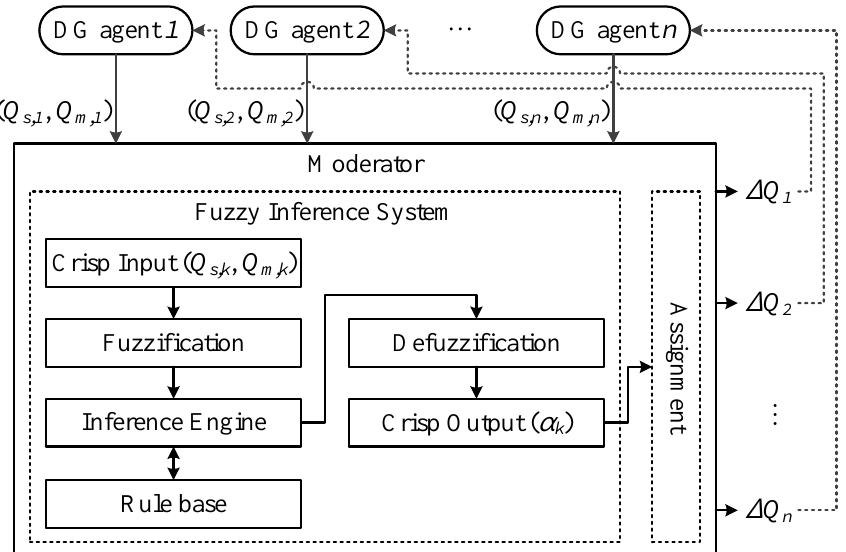
Figure 4. Configuration of the moderator.